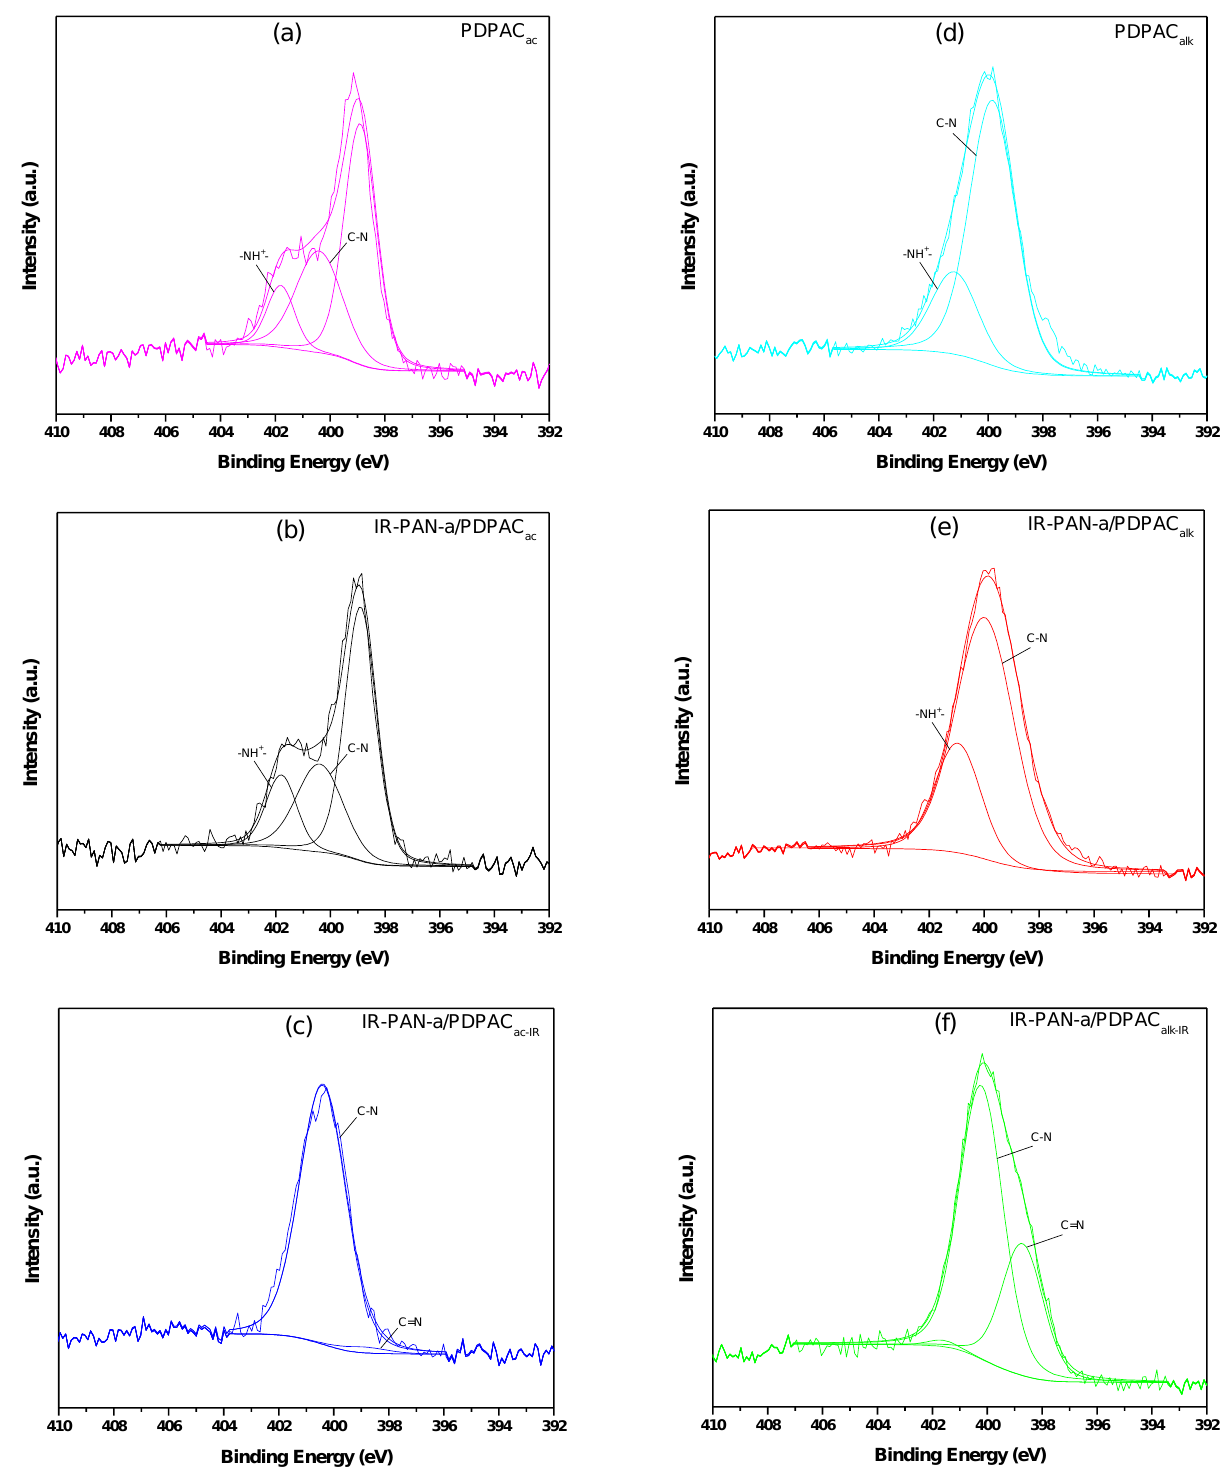
Figure 8. N1s XPS spectra of PDPAC ( a , d ), IR-PAN-a/PDPAC ( b , e ), and IR-PAN-a/PDPAC IR ( c , f )